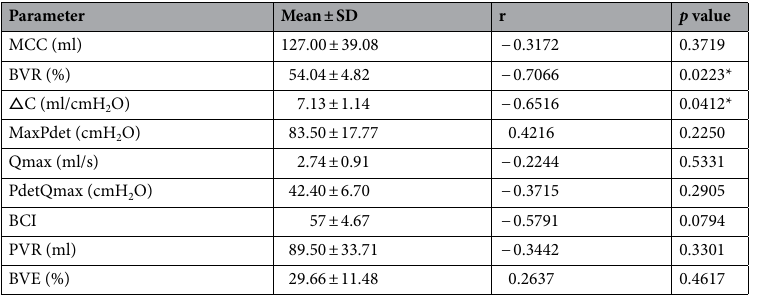
Table 1. Correlation between the expression of a-SMA and bladder function parameters. The results are expressed as the mean ± SD. Correlations were assessed by the Spearman test. MCC, maximum cystometric capacity; BVR, bladder volume ratio; △ C, compliance; maxPdet, maximum detrusor pressure during filling; Qmax, maximum flow rate; PdetQmax, pressure at the peak flow rate; BCI, bladder contraction index; PVR, postvoid residual urine volume; BVE, bladder voiding efficiency. * p < 0.05.